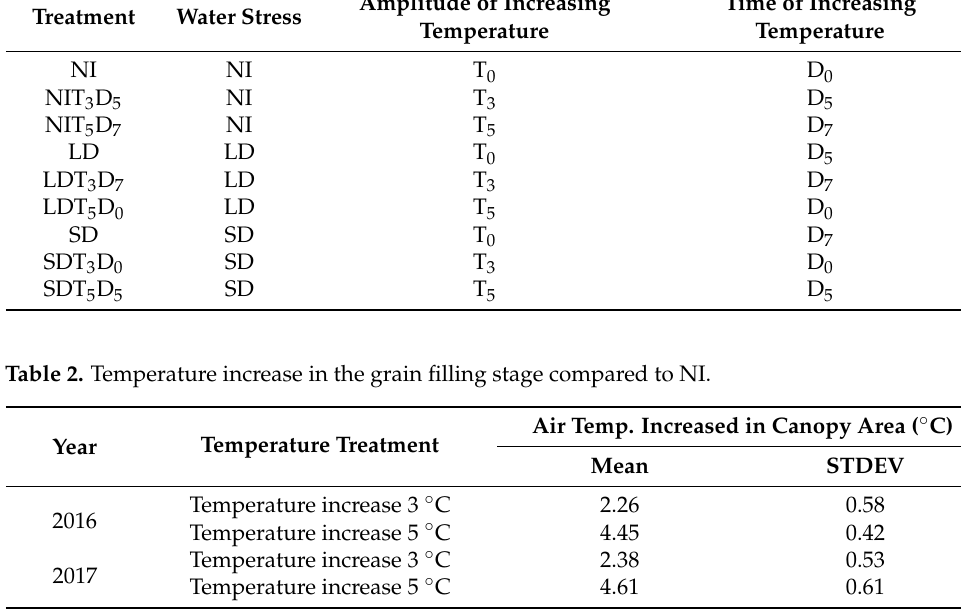
Table 1. Three-factor three-level orthogonal experiment treatments. Treatment